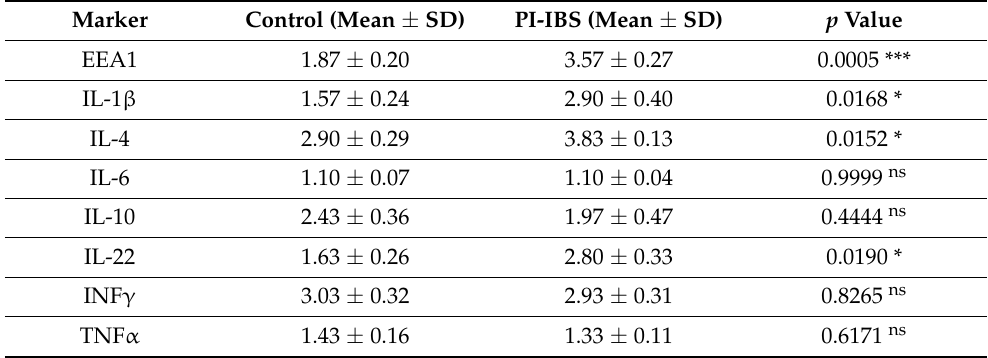
Figure 5. Immunohistochemistry of early endosome antigen-1 (EEA1) at surface enterocytes in colon mucosa of ( a ) healthy controls and ( b ) PI-IBS patients. Red: EEA1; violet: nuclei counterstaining with hematoxylin. Bar = 100 µm. Table 1. EEA1 and cytokine intensity grade (0–4) at surface cells in the colon mucosa of PI-IBS patients and